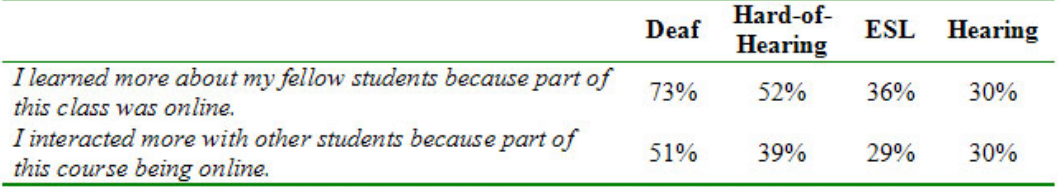
Table 1. Peer Interactions